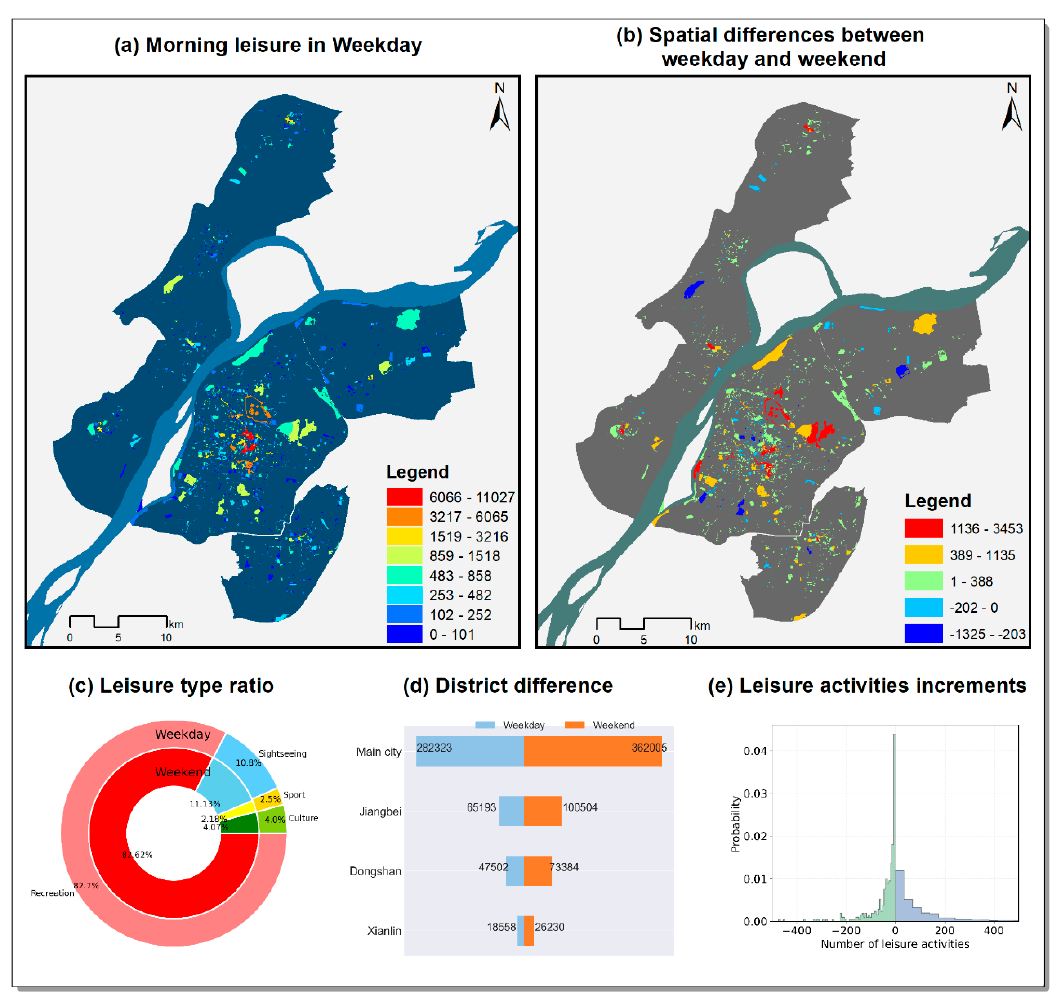
Figure 8. Comparison of morning urban leisure activity participants between weekday and weekend.